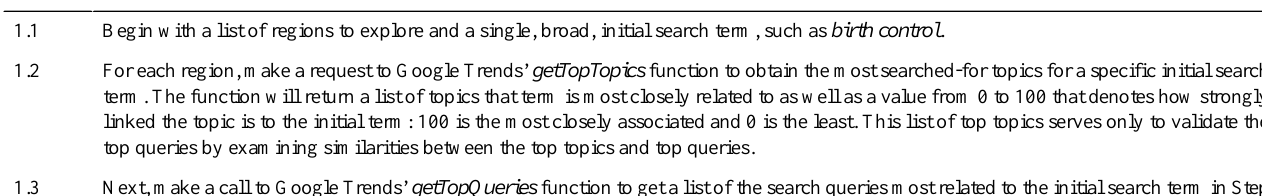
Table 1. Developing a list of top search queries. DescriptionStep